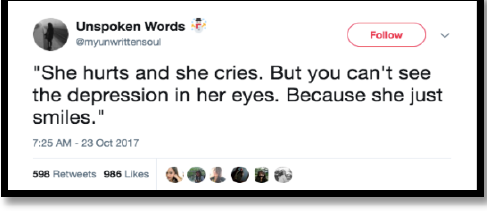
Fig.1. A depressed user pretends to be